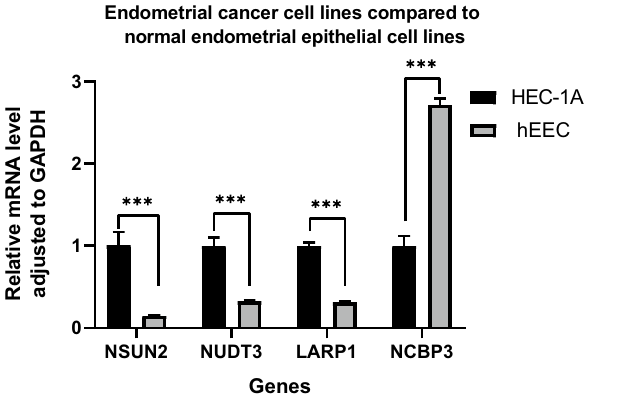
Figure 11. The result of